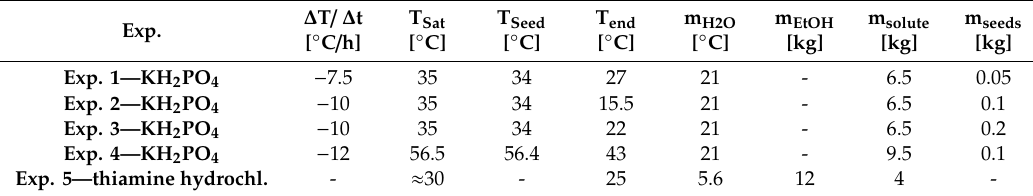
Table 2. Process conditions of the performed experiments with KH 2 PO 4 and thiamine hydrochloride. ∆ T / ∆ Exp.